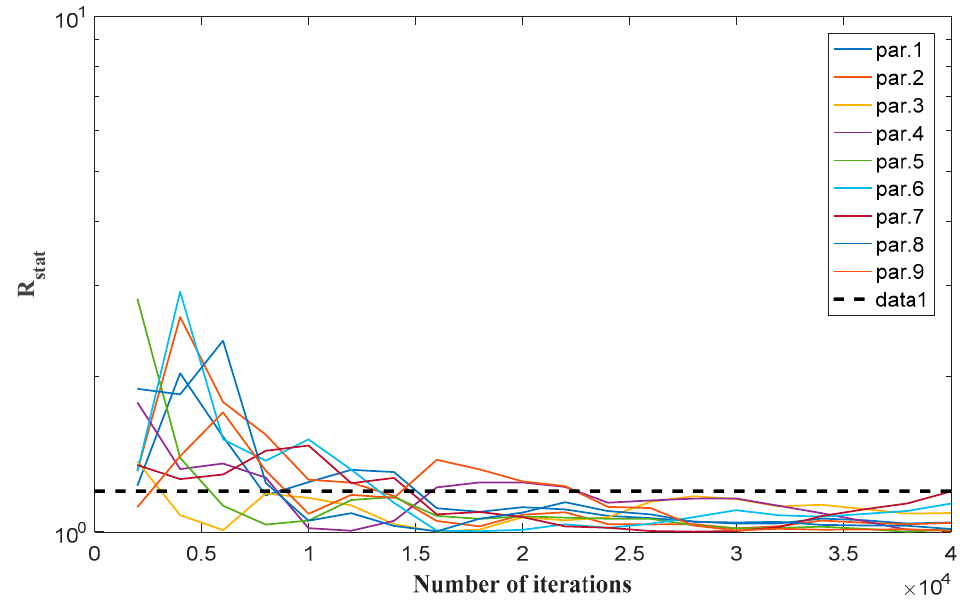
Figure 6. Convergence of the unsaturated soil parameters for the mobile–immobile transport model: Variation of the Gelman–Rubin ( R stat ) with the number of iterations. The convergence is achieved if the chains reach the threshold in broken-line ( R stat ≤ 1.2).